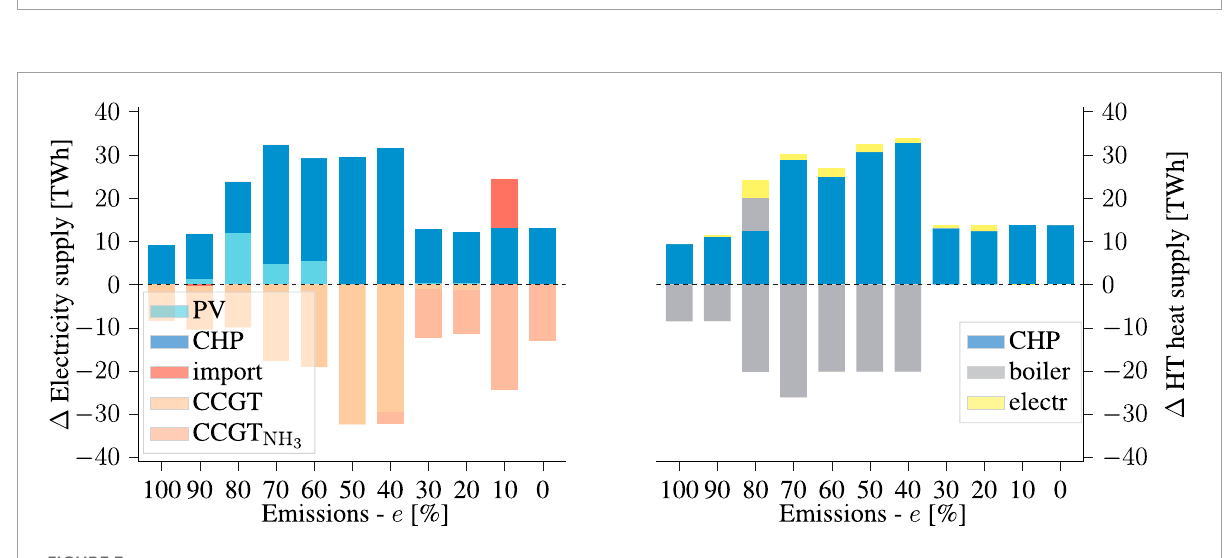
is also included in the non-energy demand. This